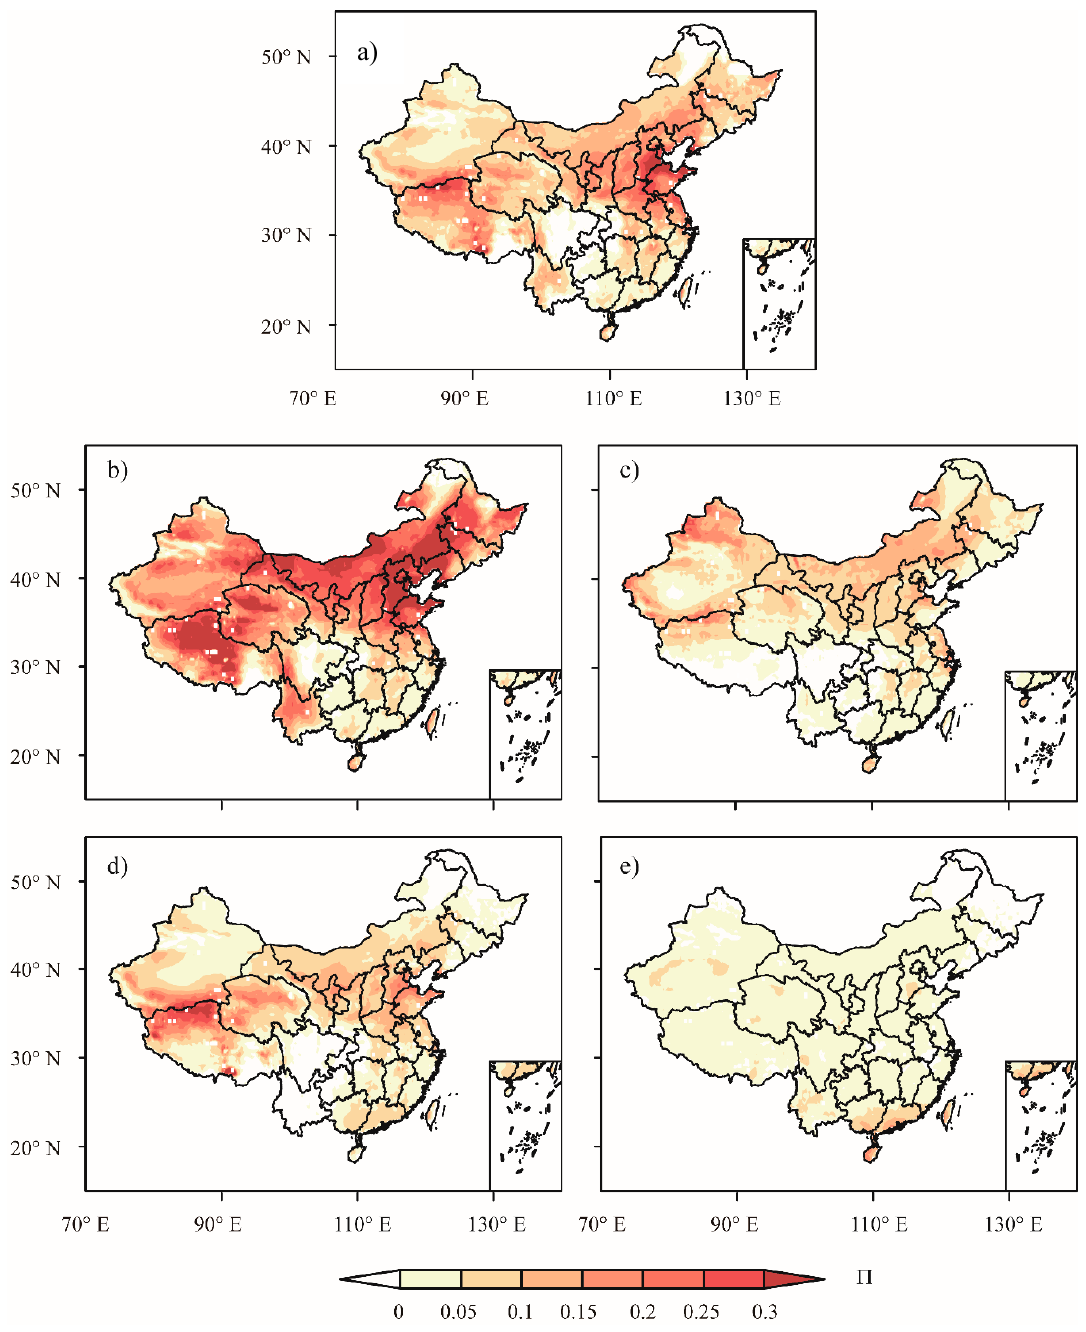
Figure 2. Soil moisture–temperature coupling over China during the period 1980–2013. ( a ) Whole year; ( b ) spring (MAM, from March to May); ( c ) summer (JJA, from June to August); ( d ) autumn (SON, from September to November); ( e ) winter (DJF, from December to February).